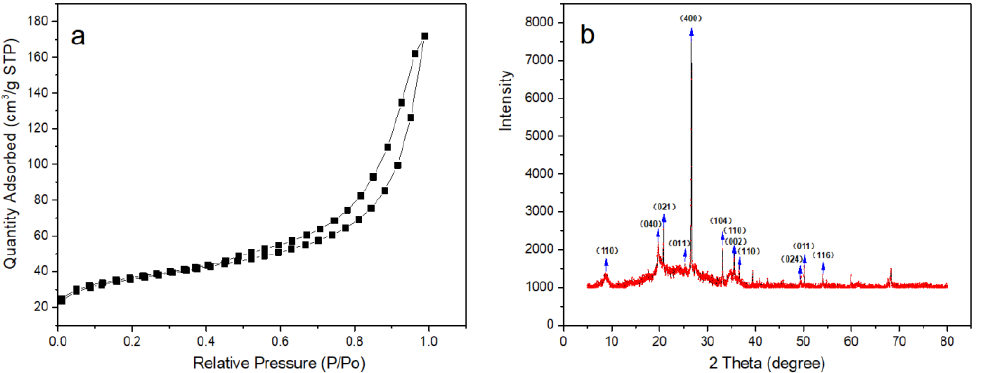
Figure 1. N 2 adsorption/desorption isotherm of granular catalyst at 77 K ( a ) and XRD ( b ). Figure 1b XRD spectra of iron-loaded catalysts shows that attapulgite characteristic diffraction peaks appeared at 2 θ = 8.5 ◦ , 19.8 ◦ , 20.3 ◦ , 27.9 ◦ , 35.7 ◦ , etc. The corresponding crystal plane spacing was D (110) = 10.3974 nm, D (040) = 4.4725 nm, D (021) = 4.3829